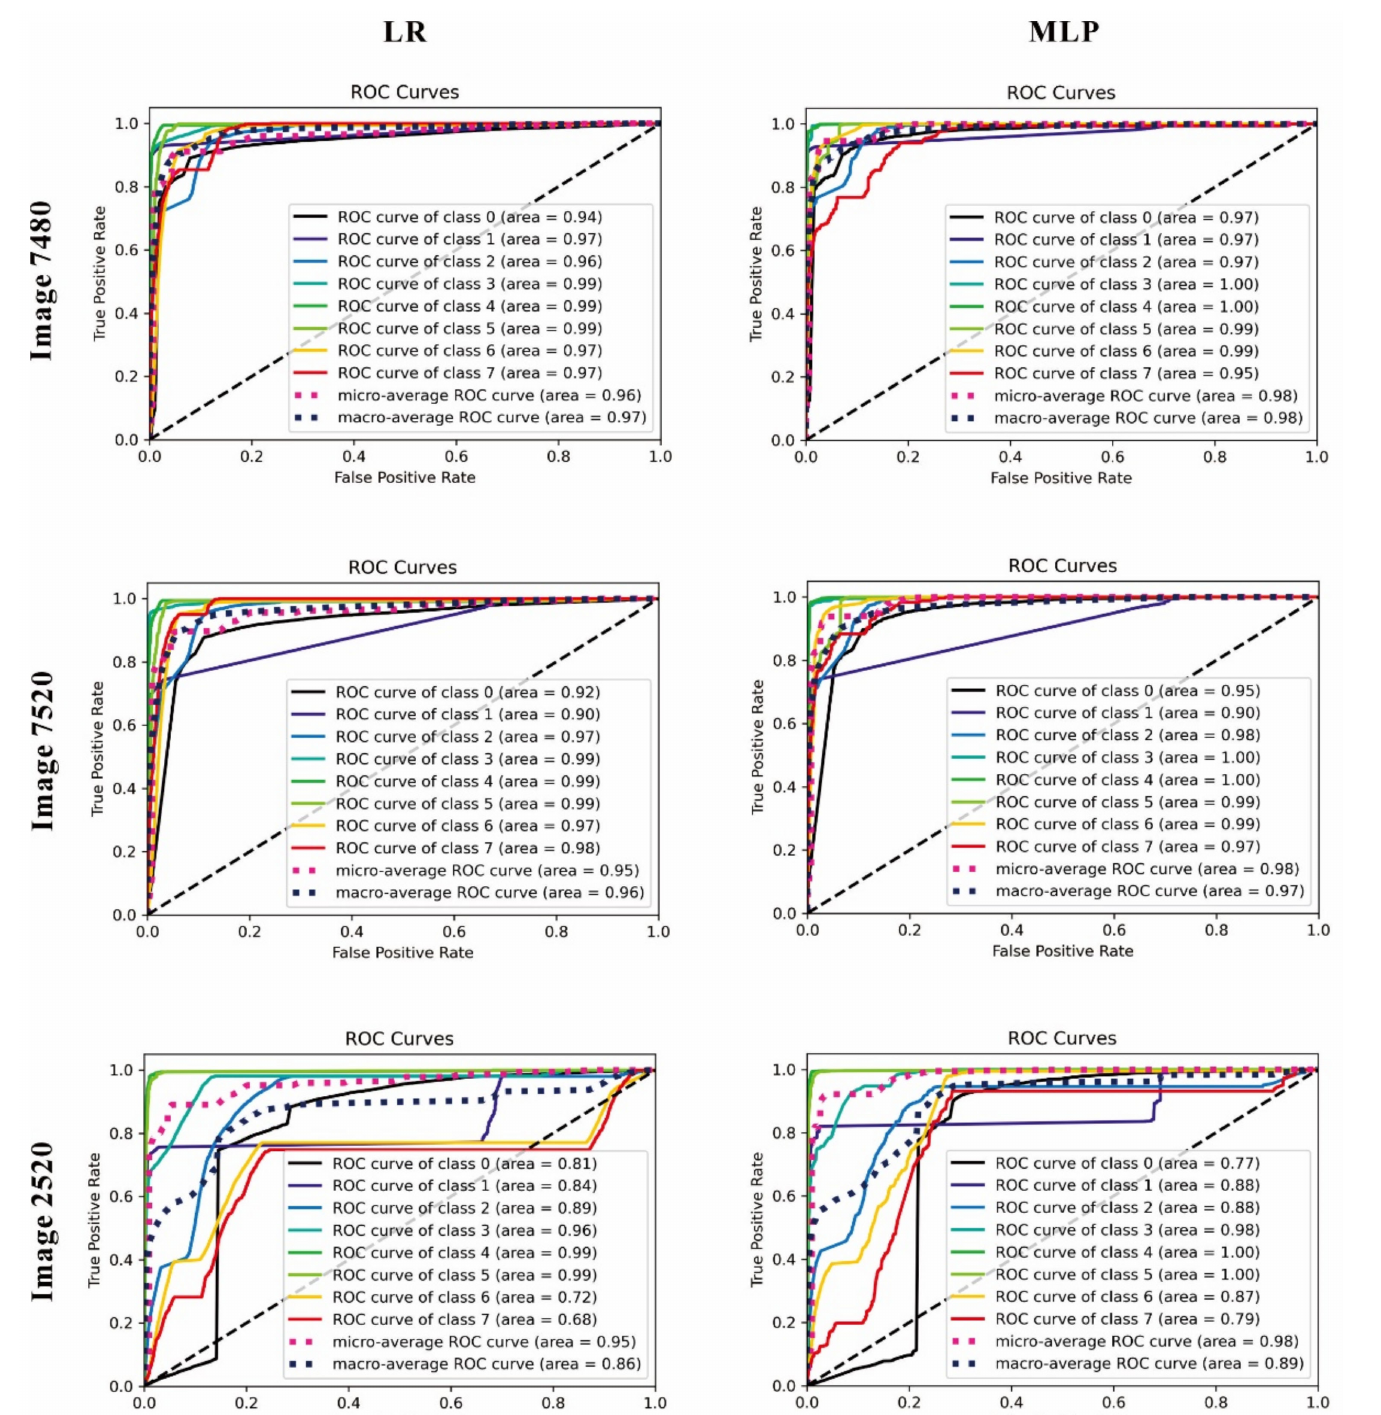
Figure 17. ROC-AUC analysis of LR and MLP classifiers in case